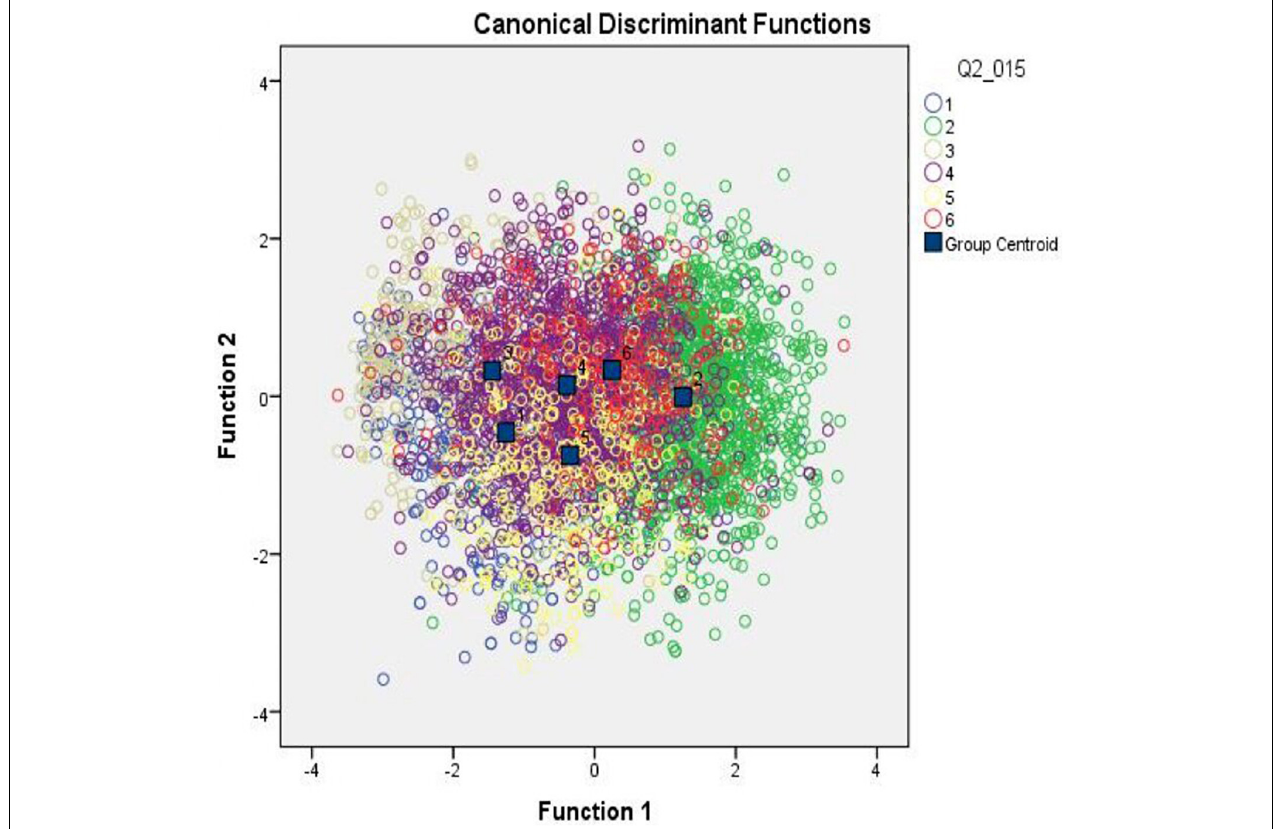
FIGURE 3 | Groups and groups’ centroid location on the discriminant functions